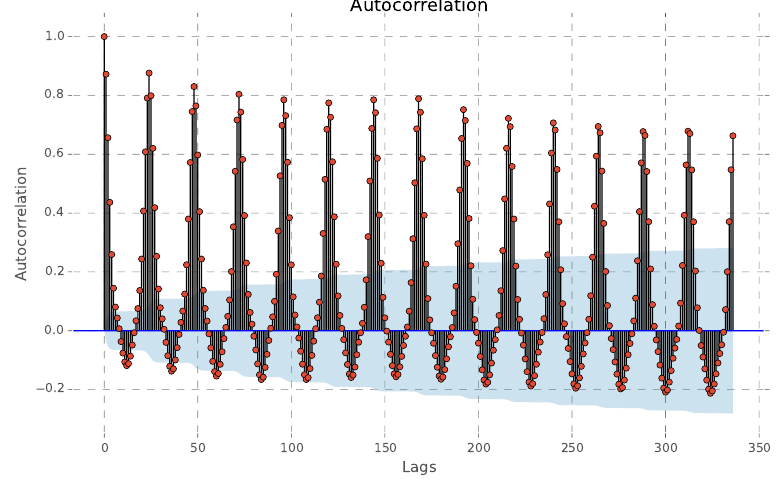
Figure 3. Auto correlation of the active energy in Network 1, from Lag zero to Lag 336 (i.e., two weeks).